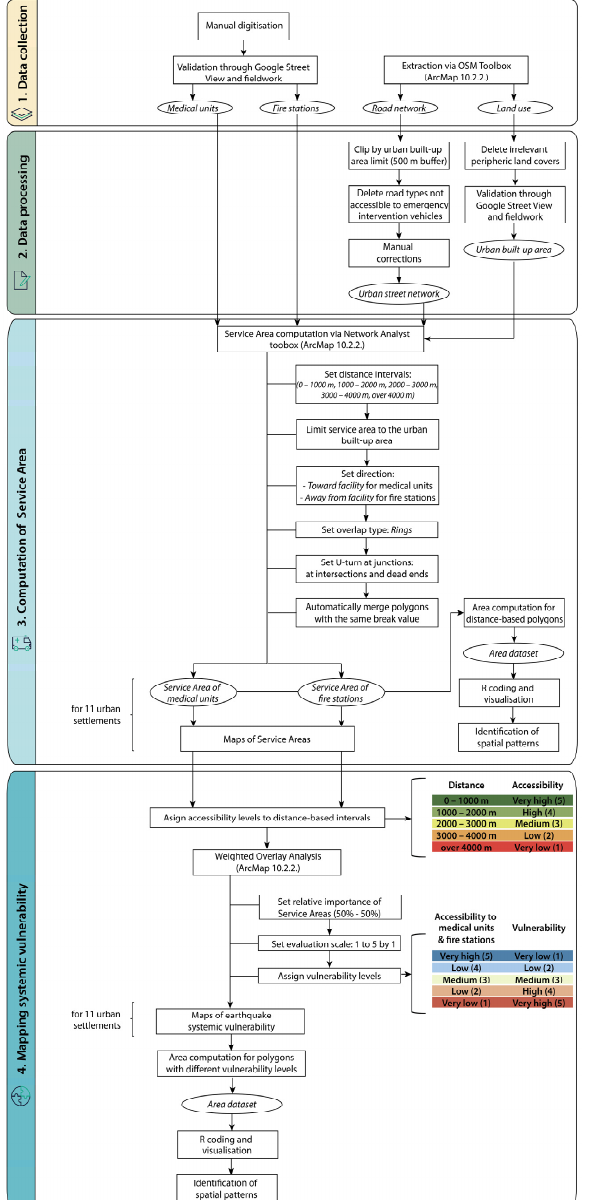
Figure 2. Methodological framework consisting of 4 steps: 1. Data collection; 2. Data processing; 3. Computation of Service Areas; 4. Mapping systemic vulnerability.